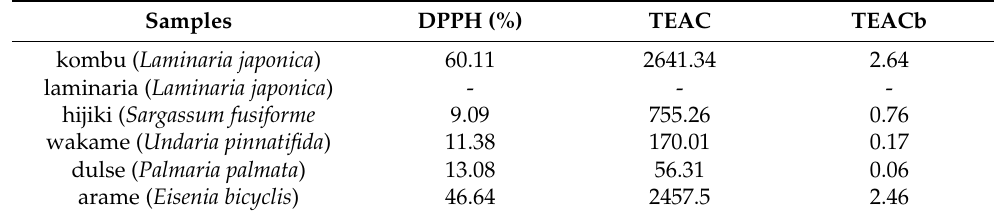
Table 1. Antioxidant activity of seaweeds.